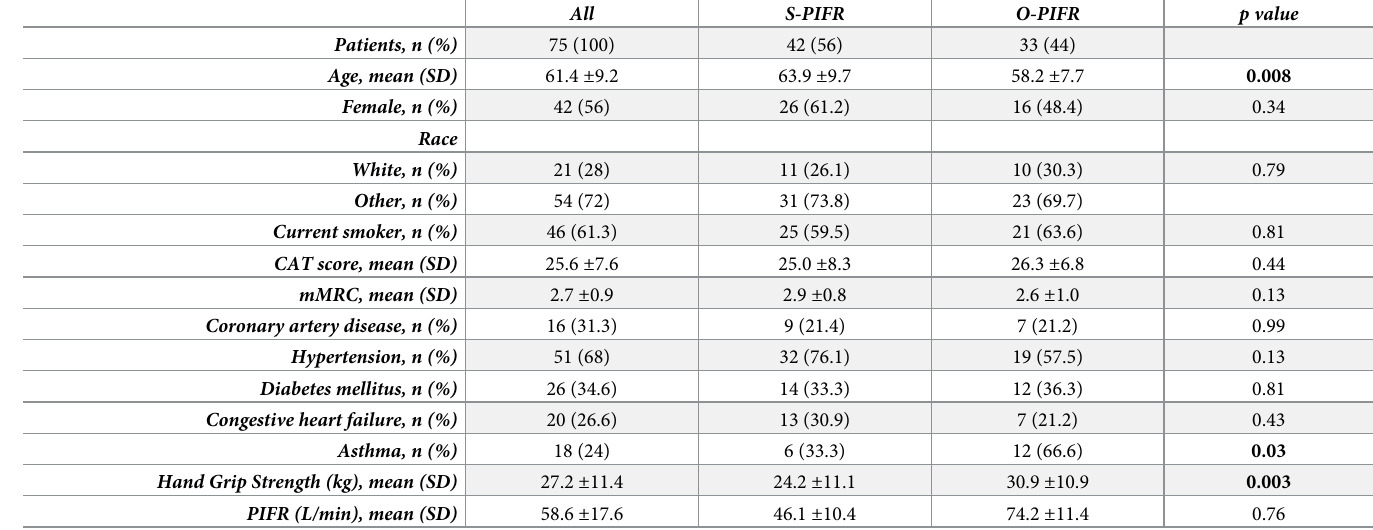
Table 1. Patient demographics and clinical characteristics for all participants and by peak inspiratory flow rate (PIFR) categories suboptimal PIFR (S-PIFR) and optimal PIFR (O-PIFR). P values: S-PIFR vs